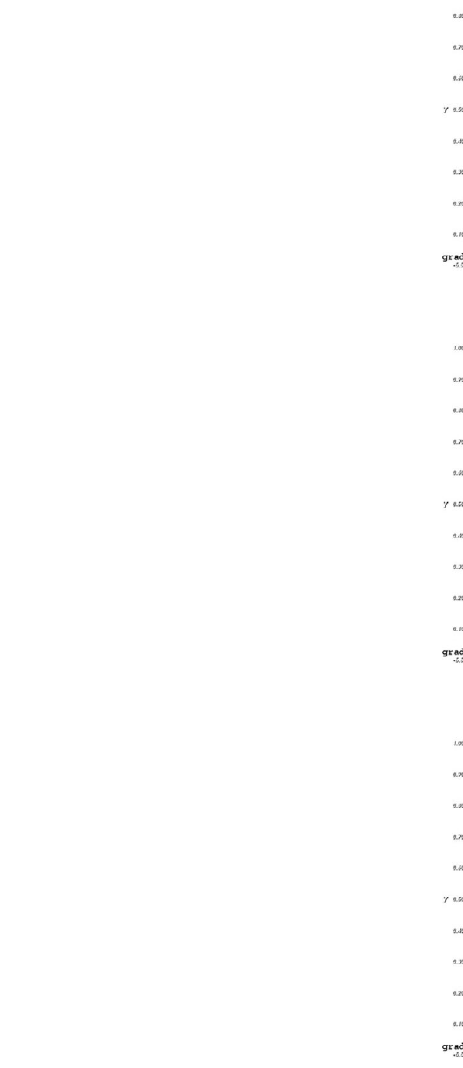
Figure 8 Isovalues of the topological gradient showing the obtained obstacle